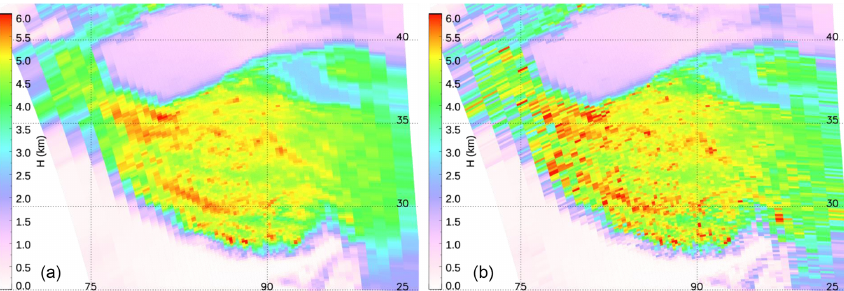
Figure A2. Pixel average terrain height for region of the Tibetan Plateau from ETOPO2v2 used in GLER (a) , and OMI L1b terrain height at the center of the pixel (b) .